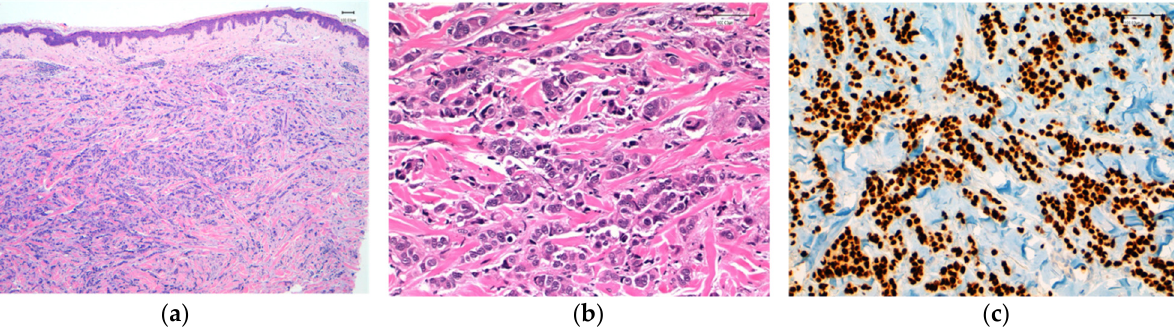
Figure 4. ( a ) Infiltrating trabecular pattern in a cutaneous nodular metastasis from a triple-negative breast carcinoma of no special type. Original magnification, 40 ×. ( b ) Tumor cells dissecting dermal collagen fibers. Original magnification, 200×. ( c ) Intense expression of GATA3 (Clon L50-823, Roche). Original magnification, 200×.